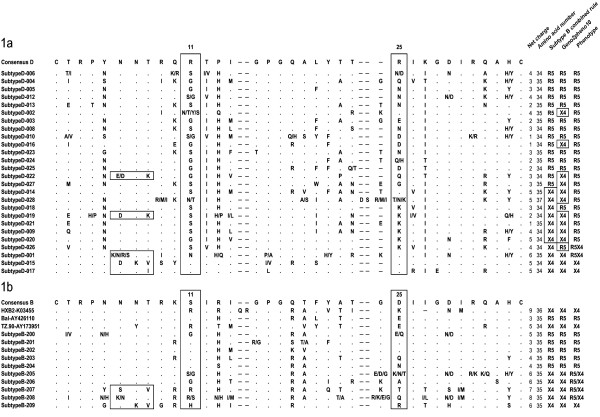
V3 amino acid sequence alignments and matched phenotypes of the 26 subtype D viruses (1a) and of 13 reference subtype B viruses (1b). V3 amino acid sequence alignments were obtained by bulk sequencing env PCR products from the 26 subtype D-infected patients, 10 subtype B-infected patients and 3 reference subtype B viruses. These sequences are shown with the following abbreviations with reference to the consensus sequences: dot, identity with amino acid baseline sequence; dash, gap inserted to maintain alignment; slash, amino acid position related to dual virus population. Replacements are indicated by the appropriate code letters. Residues at positions 11 and 25 and mutated N-linked glycosylation sites are boxed to highlight the substitutions noted. The V3 net charge (calculated by subtracting the number of negatively charged amino acids [D and E] from the number of positively charged ones [K and R]); the number of amino acids in V3; the genotype predicted by the combined 11/25 and net charge rules built for subtype B viruses and the Geno2pheno are shown, together with the observed phenotype. Discordances between the genotypic predictions and the phenotype are boxed.